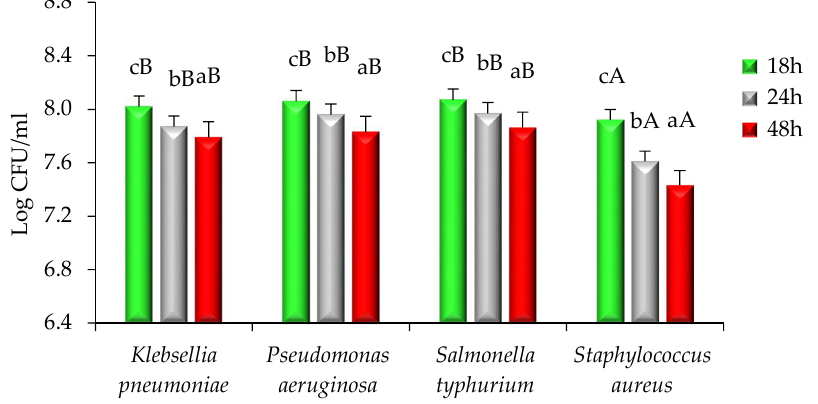
Figure 4. Time–kill kinetics of Citrus nobilis peel dry extract against the growth of food pathogenic bacteria during different time intervals. Data are presented as means ± SEM ( n = 3); a–c: Means within the column with different lowercase superscripts are significantly different ( p < 0.05); A,B: Means within the row with different uppercase superscripts are significantly different ( p < 0.05) from each other.